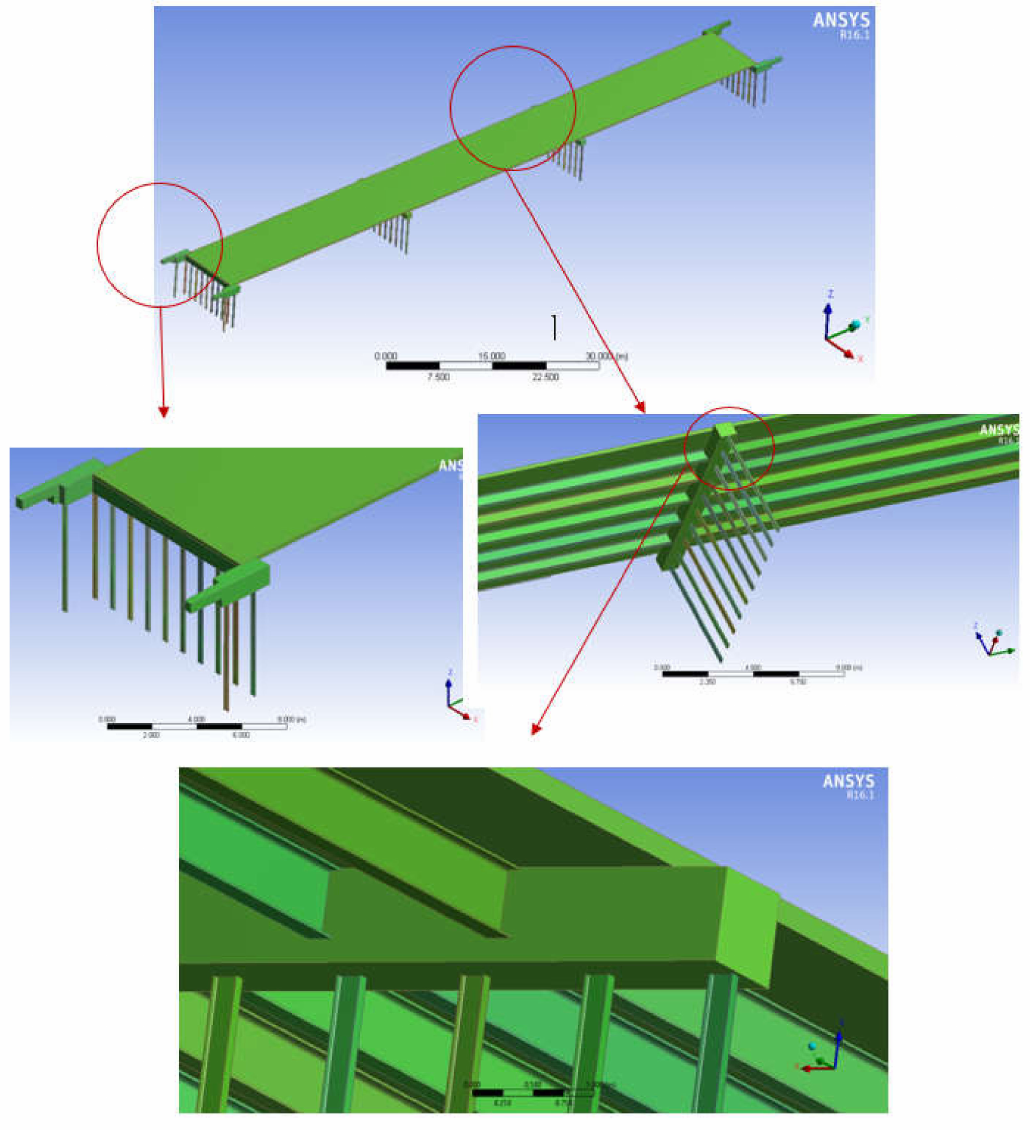
Figure 3. The details of the geometric model of an integrated concrete bridge with steel